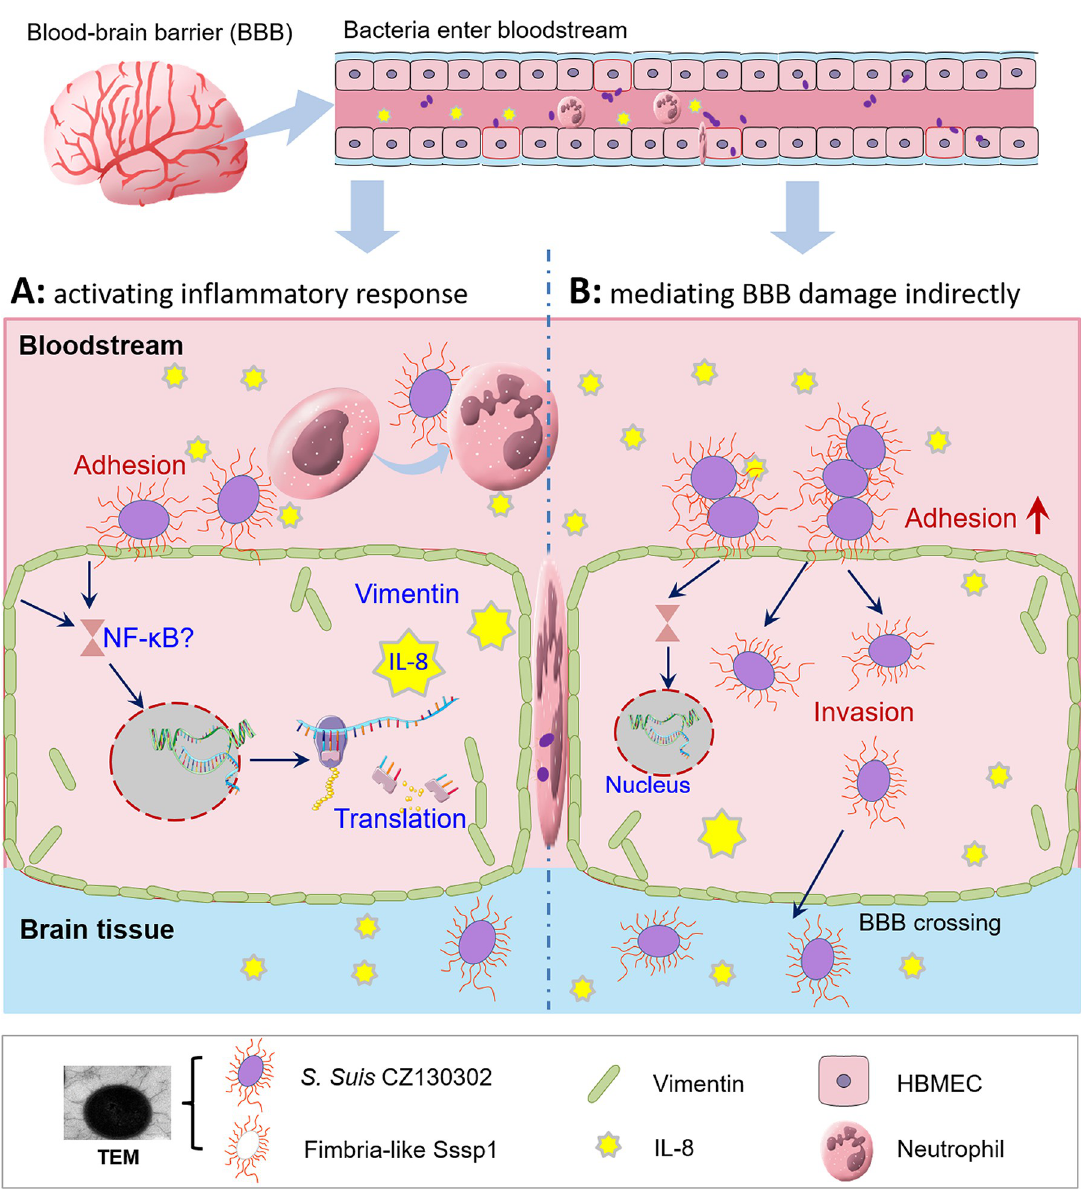
Fig 8. Summary of the role of the SssP1-vimentin interaction in promoting meningitis. SssP1 interacts with vimentin on the surface of HBMECs to promote S . suis attachment and induce robust inflammatory responses, which contributes to destroying the BBB to cause meningitis indirectly. The transmission electron microscope (TEM) image of S . suis strain CZ130302 showing the fimbria-like construction of SssP1 proteins was observed by this study, which was is consistent with a previous study of our lab